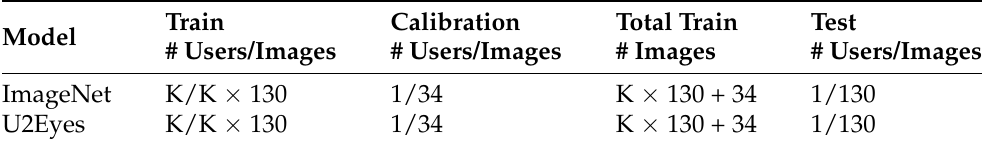
Table 2. Original configurations of the different experiments according to the training mode, U2Eyes or ImageNet, and the number of users and images in the training and testing phase. The K parameter varies from 0 to 11, i.e., 0 indicates that none of the subjects of the I2Head dataset has been included to train the model, except for the subject to be calibrated, and 11 indicates that all the additional subjects are present in the training phase. For the calibration, 34 images of the subject are employed while the test is conducted over 130 subject images unseen by the model.